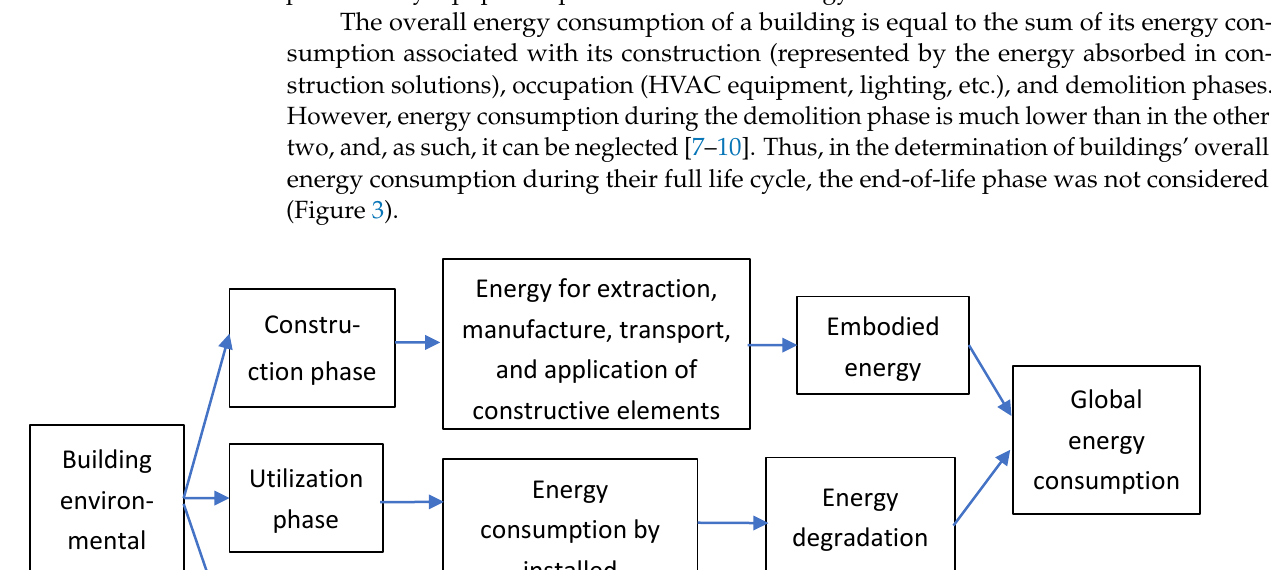
Figure 2. Measured versus predicted energy consumption of the high school during 2014.